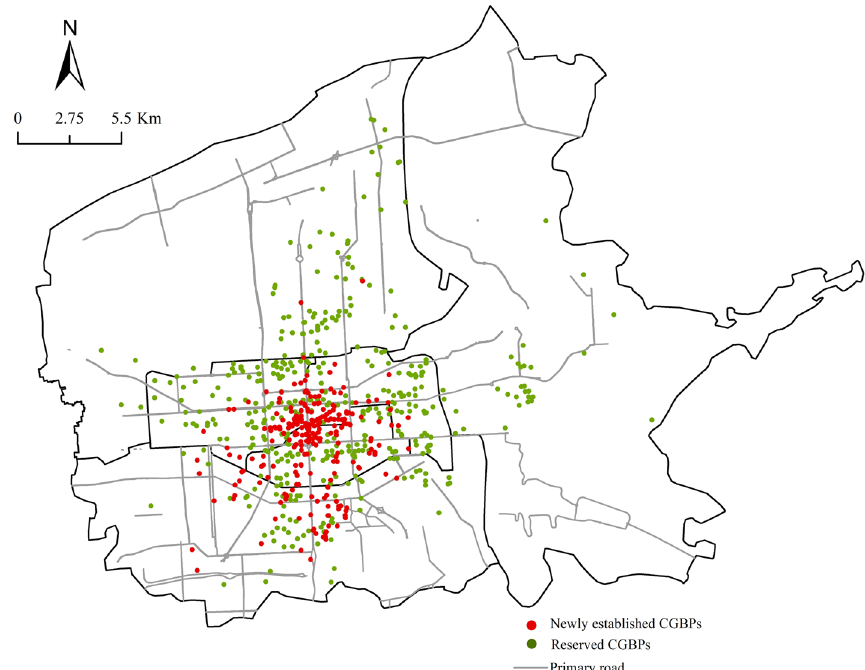
Fig. 8 Location Optimization of CGBPs